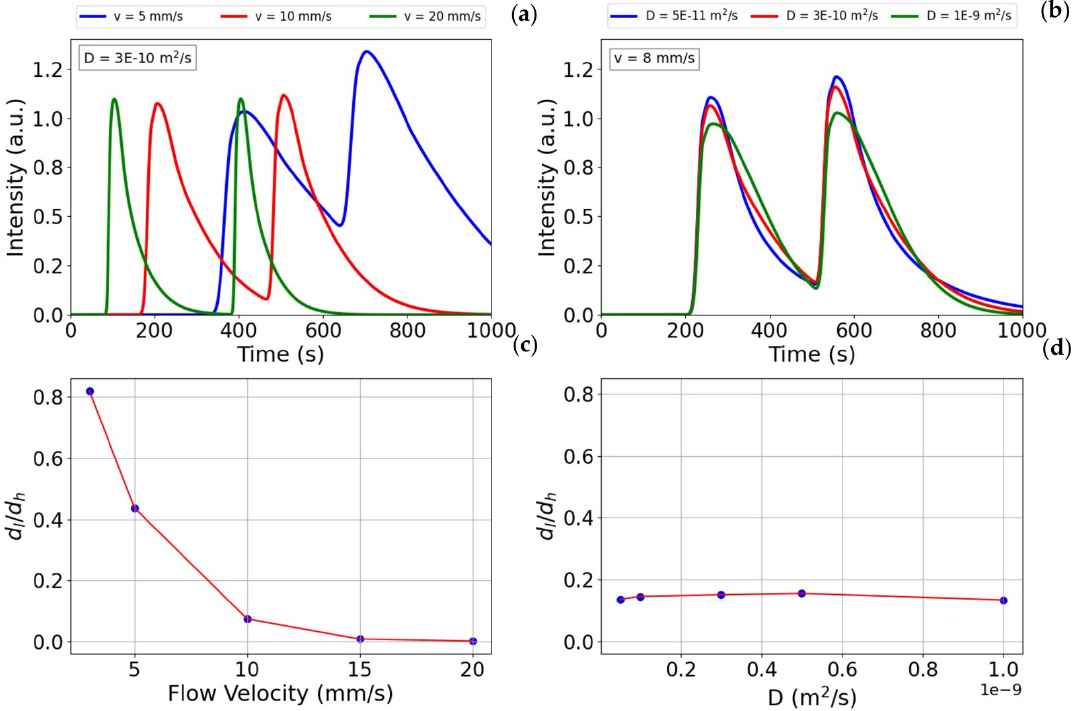
Figure 5. ( a , b ) Simulated signals representing two consecutive bits with a fixed delay between them of 300 seconds, colors are associated with different values of flow velocity and diffusion coefficient, respectively; ( c , d ) development of the d l /d h ratio as a function of flow velocity and diffusion coefficient,